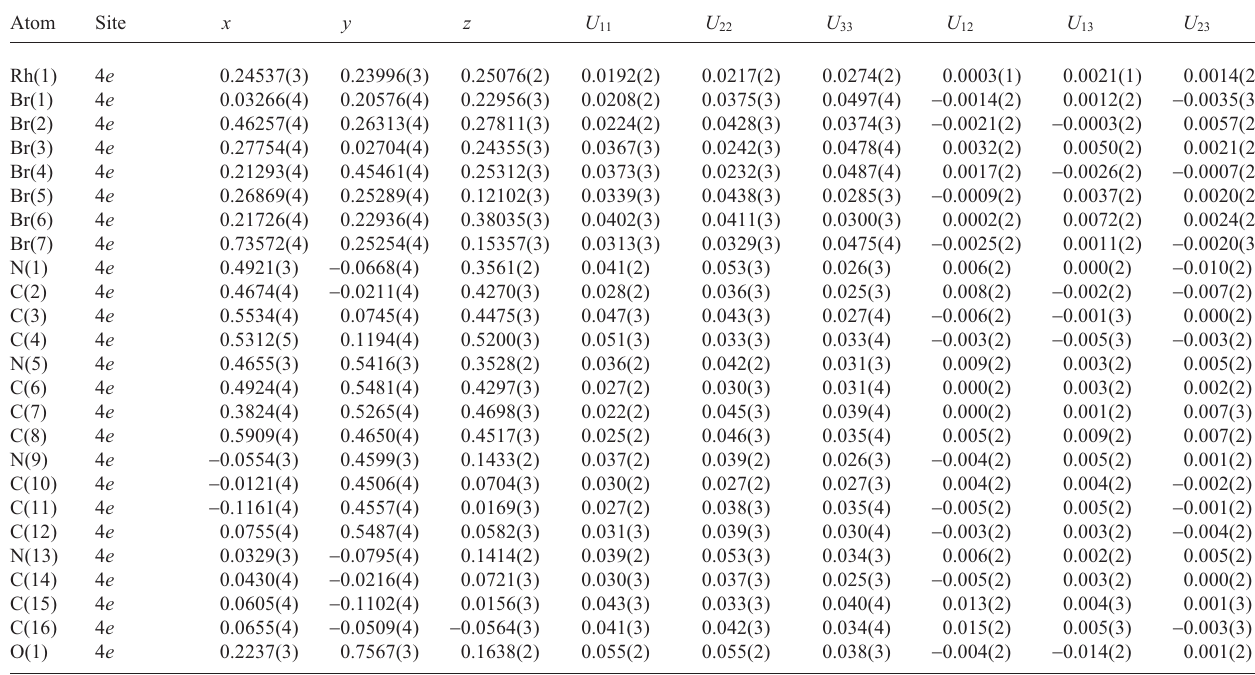
Table 3. Atomic coordinates and displacement parameters (in Å 2 )